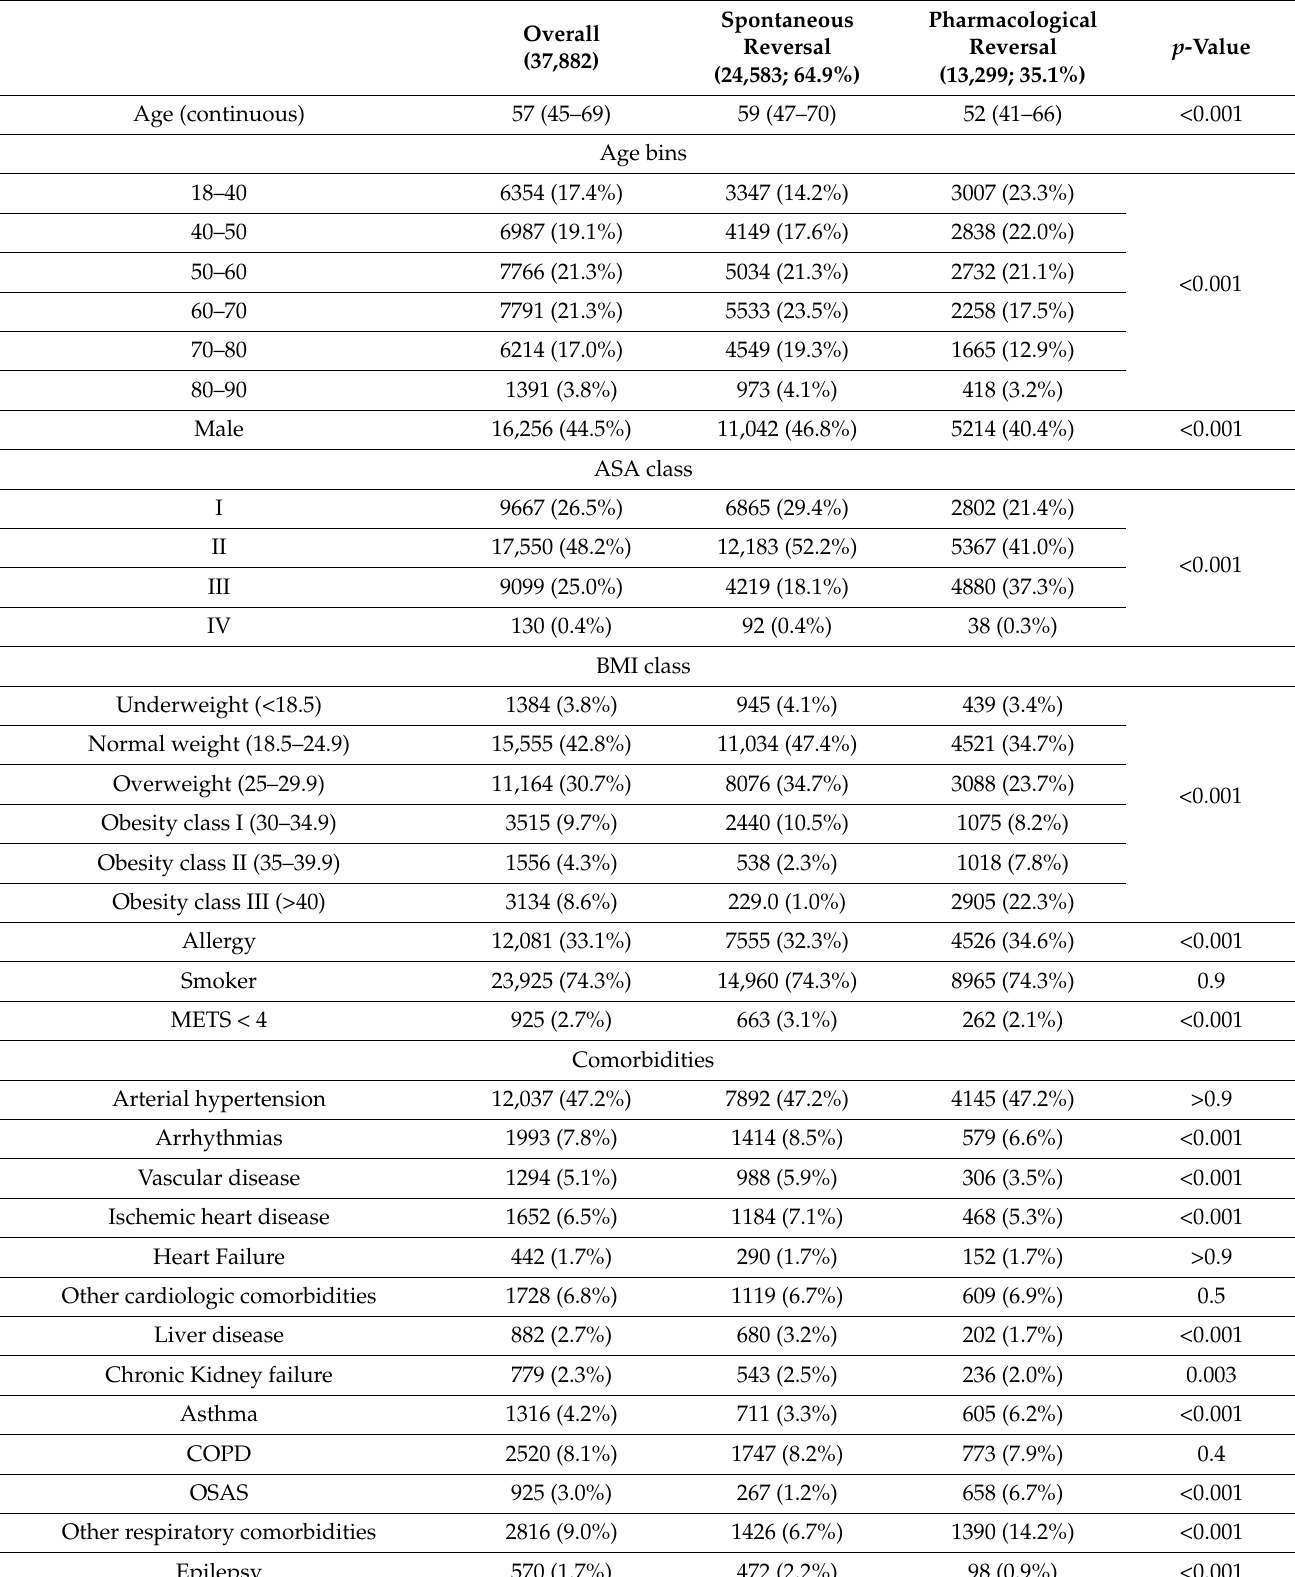
Table 1. Demographics and baseline characteristics of the NMB reversal population vs. the NMB non reversal